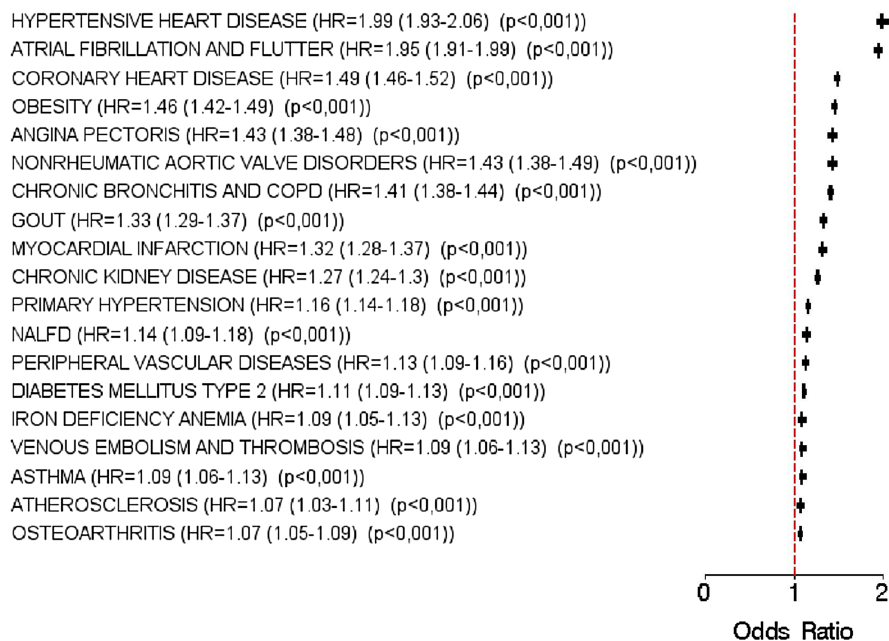
Figure 2. Association between different diagnoses and heart failure in patients followed in general practices in Germany (multivariable logistic regression